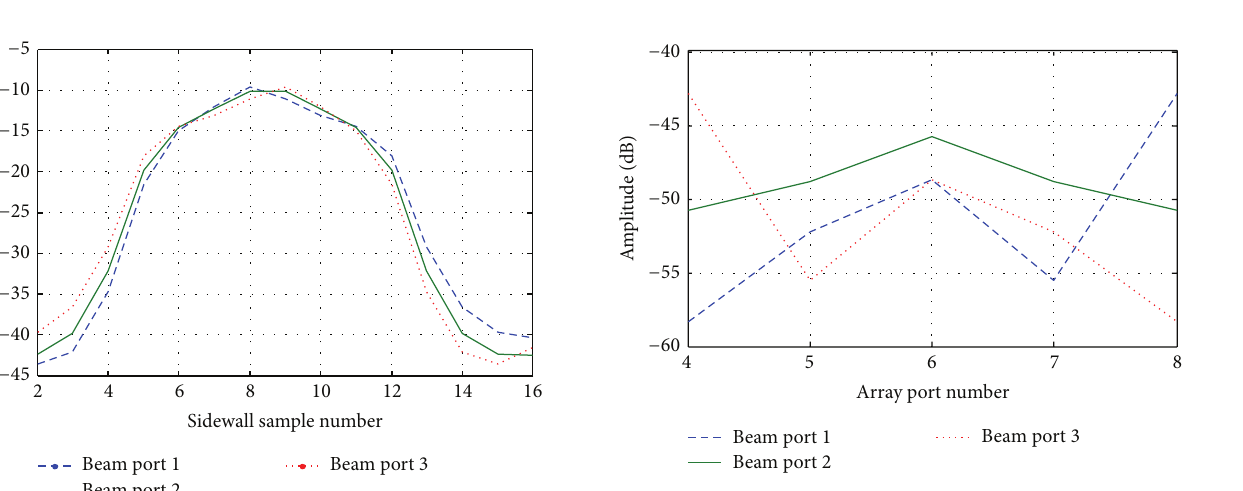
Figure 6: Beam to array spillover coupling